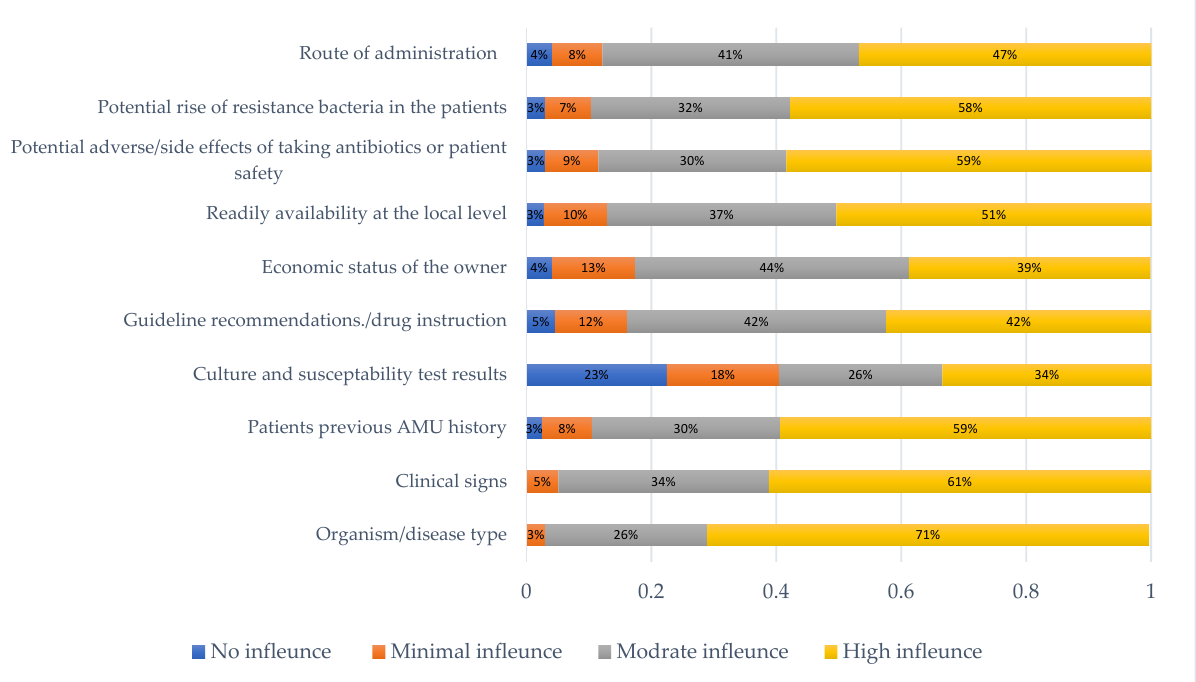
Figure 1. Sources of information on AMR for participants.